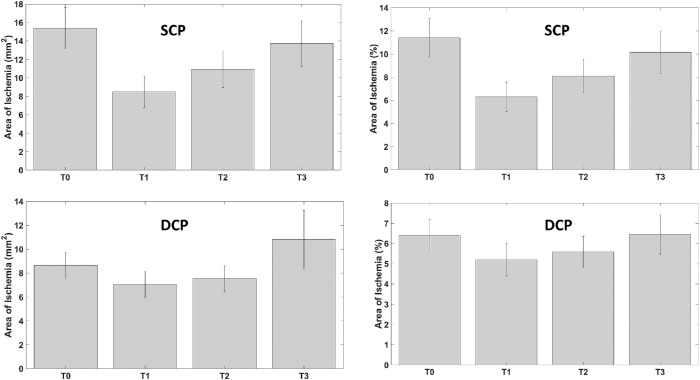
Retinal nonperfusion retinal capillary areas modification during follow-up of SCP (top, in square millimeters and in percentage) and of DCP (bottom, in square millimeters and in percentage).